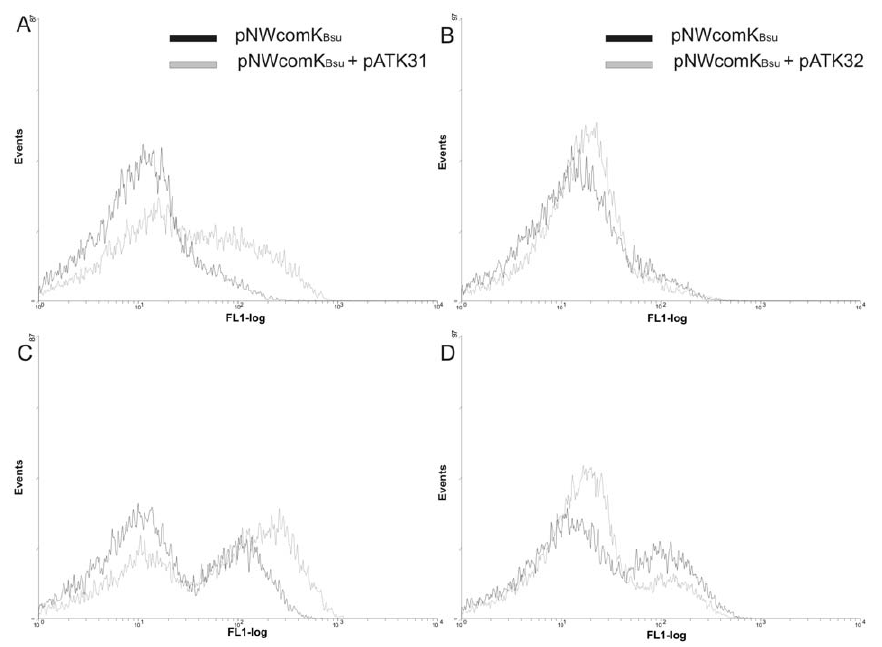
Figure 3. Flow cytometric analyses of PcomGA-gfp after overexpression of comK Bsu in the wild type containing pNWcomK Bsu (black) and in the co-expressed comK Bsu and comK1 (pATK31(A,C)) or c omK2 (pATK32(B,C)) (gray). The samples were analyzed in three hours after IPTG induction; panels A,B- strains without induction, panels C,D- strains after induction with IPTG. The numbers of cells are indicated on the y axis, and their relative fluorescence levels are indicated on the x axis on a logarithmic scale. For each experiment at least 20,000 cells were analysed. The graphs are the representative of at least three independent experiments.